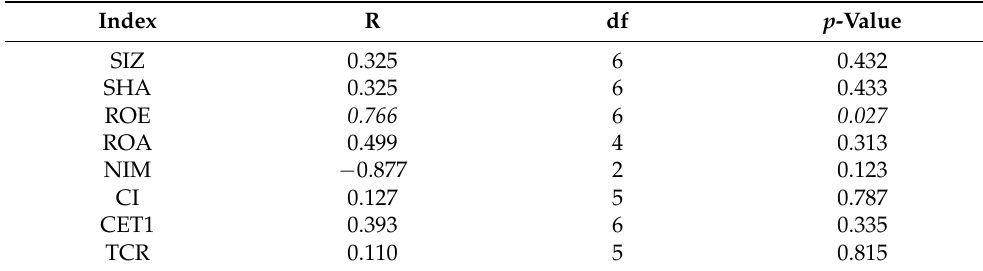
Table 7. The correlation between the BEB index and financial indicators (2019).